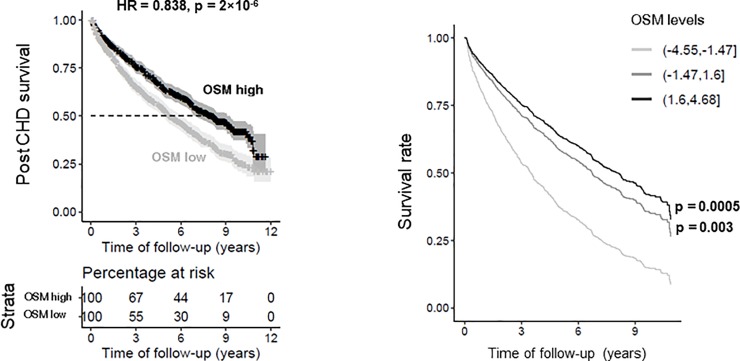
High OSM is associated with reduced post CHD mortality.Serum OSM levels of CHD patients were significantly associated with CHD related mortality rates when comparing the lower 25% quantile to the upper 75% quantile in OSM levels (hazard ratio (HR) = 0.838, p = 2×10−6) (A), and in the adjusted survival curves for the Cox model for three groups of OSM protein levels (top vs. bottom HR = 0.618, p = 0.0005) (B). Cox proportional hazards regression was performed to test for statistical significance and Kaplan-Meier plots were applied to display the survival data.